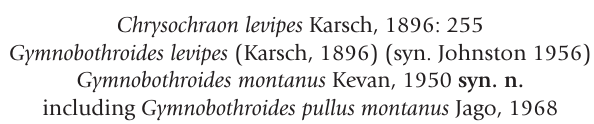
J ournal of o rthoptera r esearch 2019, 28(1)